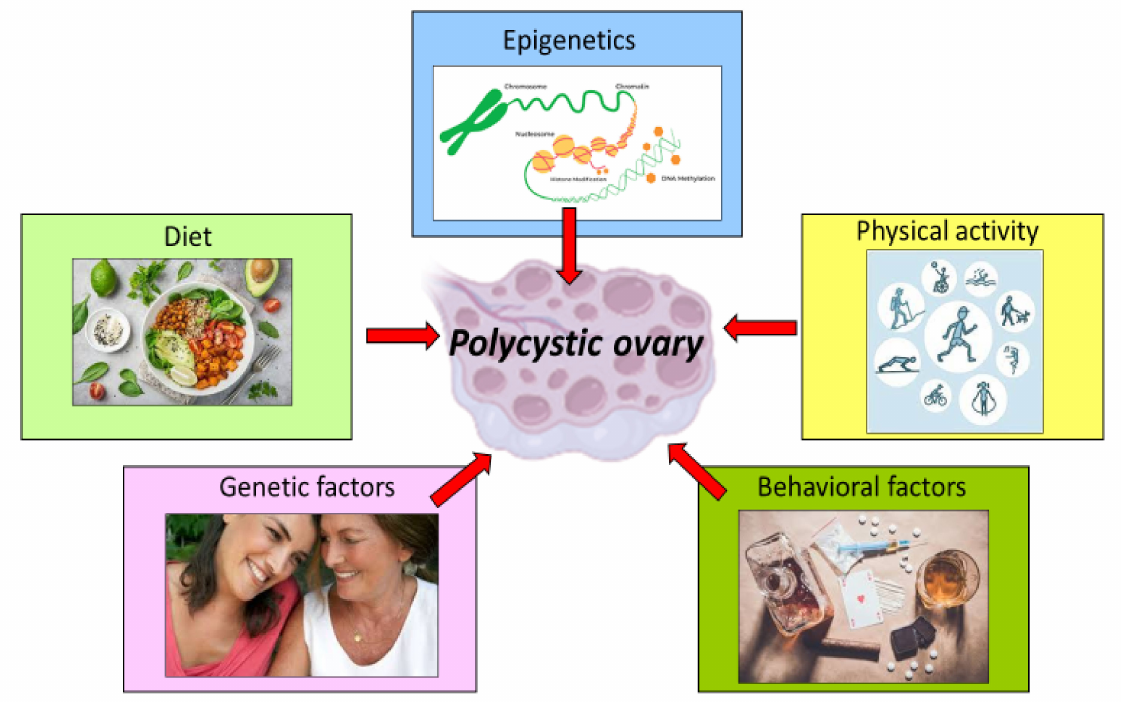
Figure 1. Genetic, environmental and behavioral factors involved in the pathogenesis of